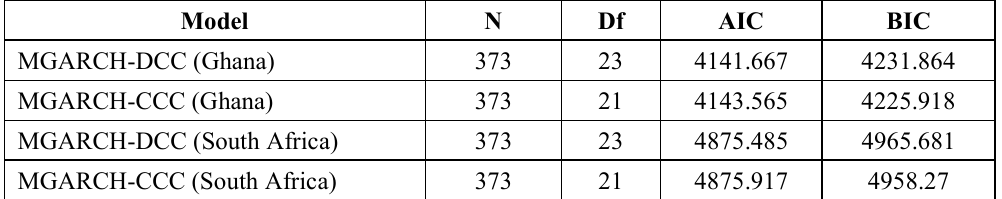
Table 2. Akaike Information Criterion and Bayesian Information